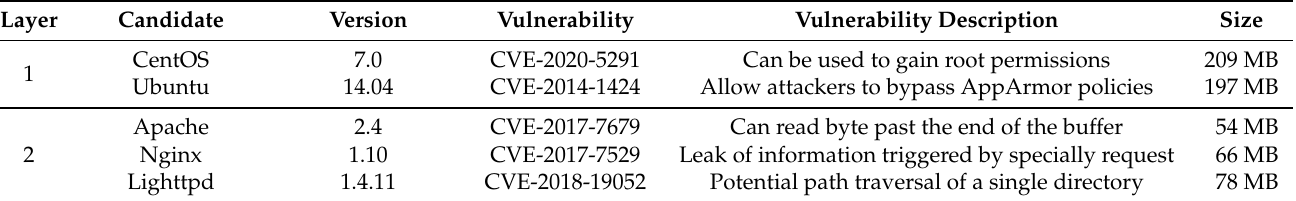
Table 2. Detail information of the mimic layers.